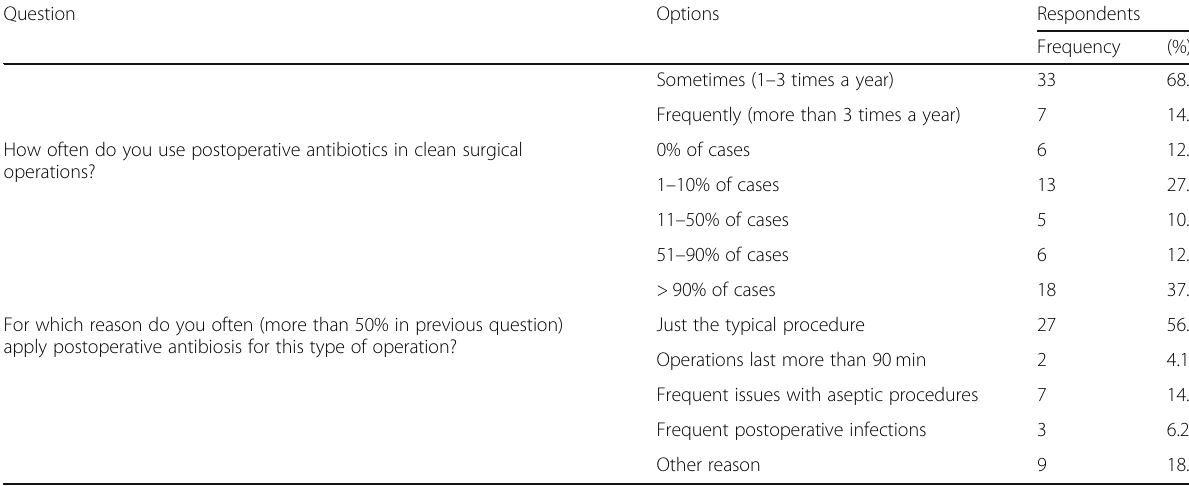
Table 1 Questionnaire responses (frequency and percentage) by the 48 respondents (Continued) Question